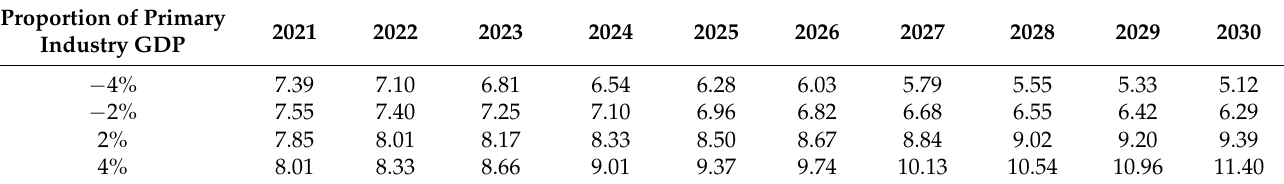
Table 9. Proportion of primary industry GDP under different growth rates.